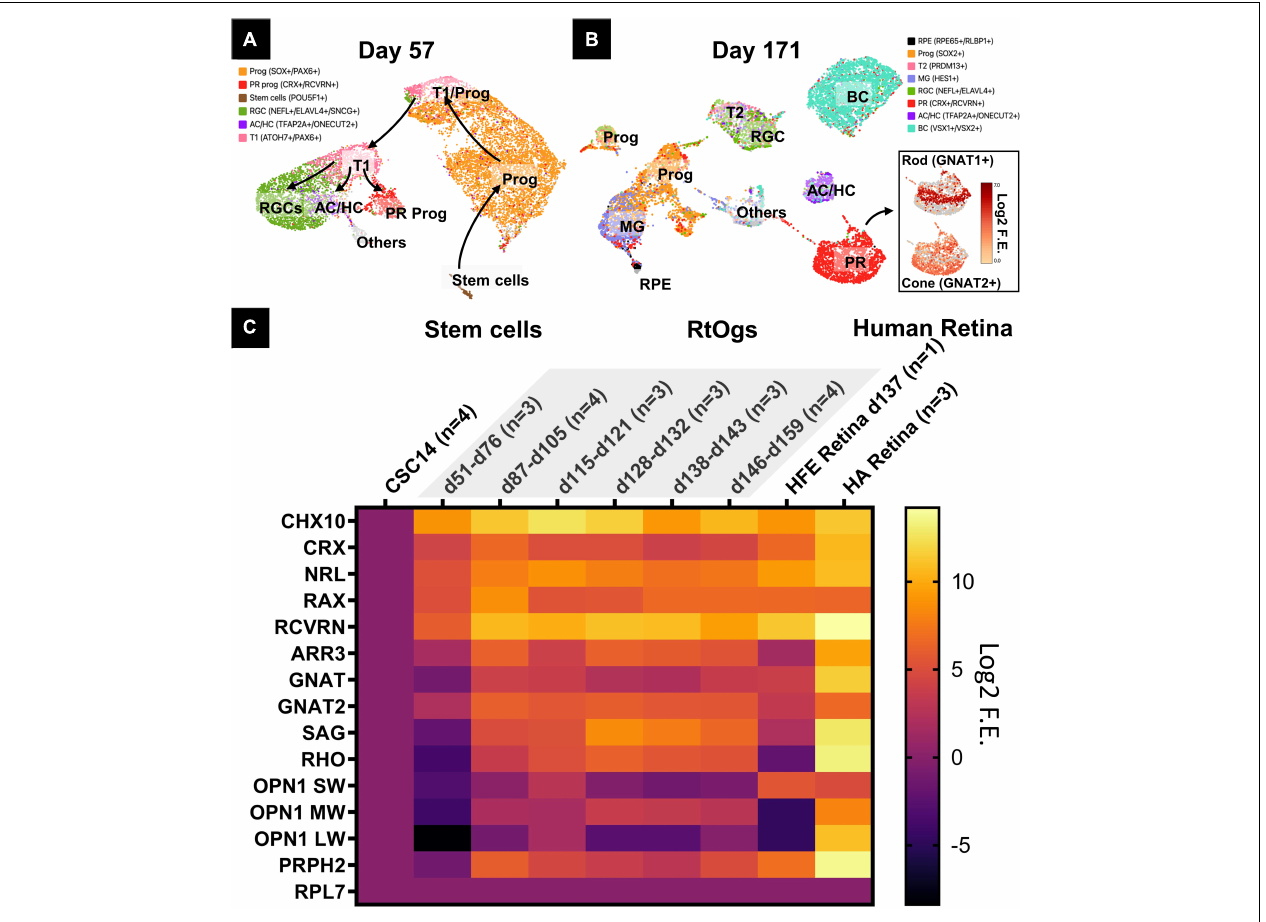
FIGURE 3 | Gene profiles of RtOgs at different ages. (A,B) sRNA-seq UMAP showing the cell types in young (D57) and mature (D171) RtOgs. (C) qPCR heatmaps of RtOgs at various differentiation stages. CSC-14 hESCs derived RtOgs (negative control) were grouped according to similar day ranges. RPL7 was the housekeeping gene used for reference. Human fetal retina (HFE) and adult retina (HA) were used as positive control. Log 2 F.E. – Log 2 (Fold Expression). Cell legends in (A,B) Prog – retinal progenitor cell; RGC – retinal ganglion cell; PR prog – photoreceptor progenitor cell; T1 – cell in transition phase 1; AC/HC – amacrine cells and horizontal cells; BC – bipolar cells; T2 – cell in transition phase 2; PR – photoreceptor cell; RPE – retinal pigment epithelium